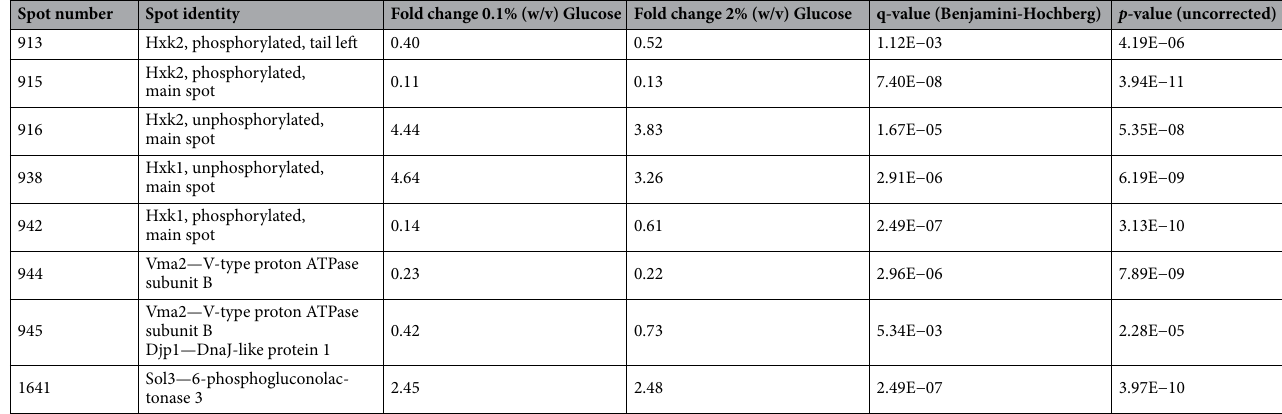
Table 1. TDA1- dependent proteins of yeast strain BY4742. The listed proteins were determined to be TDA1 - dependent via 2D-DIGE in the course of the proteomic comparison of BY4742 wild type and Δ tda1 deletion mutant cells. Spot identification is based on mass-spectrometric peptide analysis (LC/ESI–MS/MS) and subsequent determination of the protein most probable to be causing the change in fluorescence observed via 2D-DIGE. The taken steps are described in detail in the Experimental procedures section. The hexokinases Hxk1 and Hxk2 were identified as spot identities for multiple spots. Therefore, the respective spot identities are supplemented by a short description. The phosphorylation state was hypothesized based on the gel positions and later verified by mass spectrometry. The description as "tail" indicates an individual spot, which appears to be connected to a main spot of higher volume within close proximity. The given fold changes refer to the comparison of protein quantities measured by 2D-DIGE in the Δ tda1 deletion mutant proteomes and in the wild type proteomes (ratio Δ tda1 /WT). The q- and p -values were calculated by ANOVA for the effect of the TDA1 deletion, independent of glucose